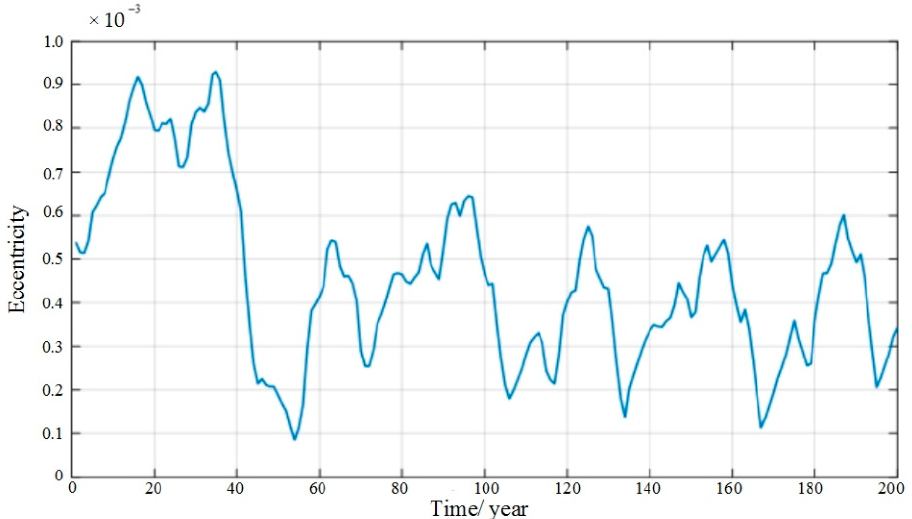
Figure 18. Variations in the eccentricity of the optimal disposal orbit. Figure 19 shows the variations in the minimum perigee and the maximum apogee of the optimal disposal orbit.